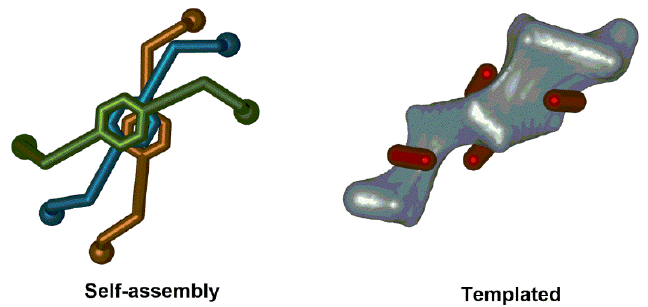
Figure 6. Representation of self-assembly and template-guided self-assembly processes to reach collective chirality in 3D nanoarchitectures.